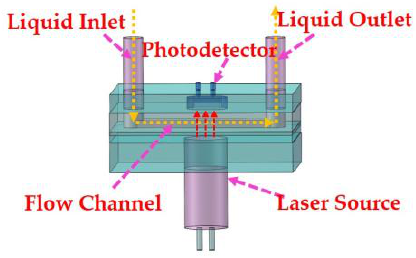
Figure 1. The structure design of the colorimeter.